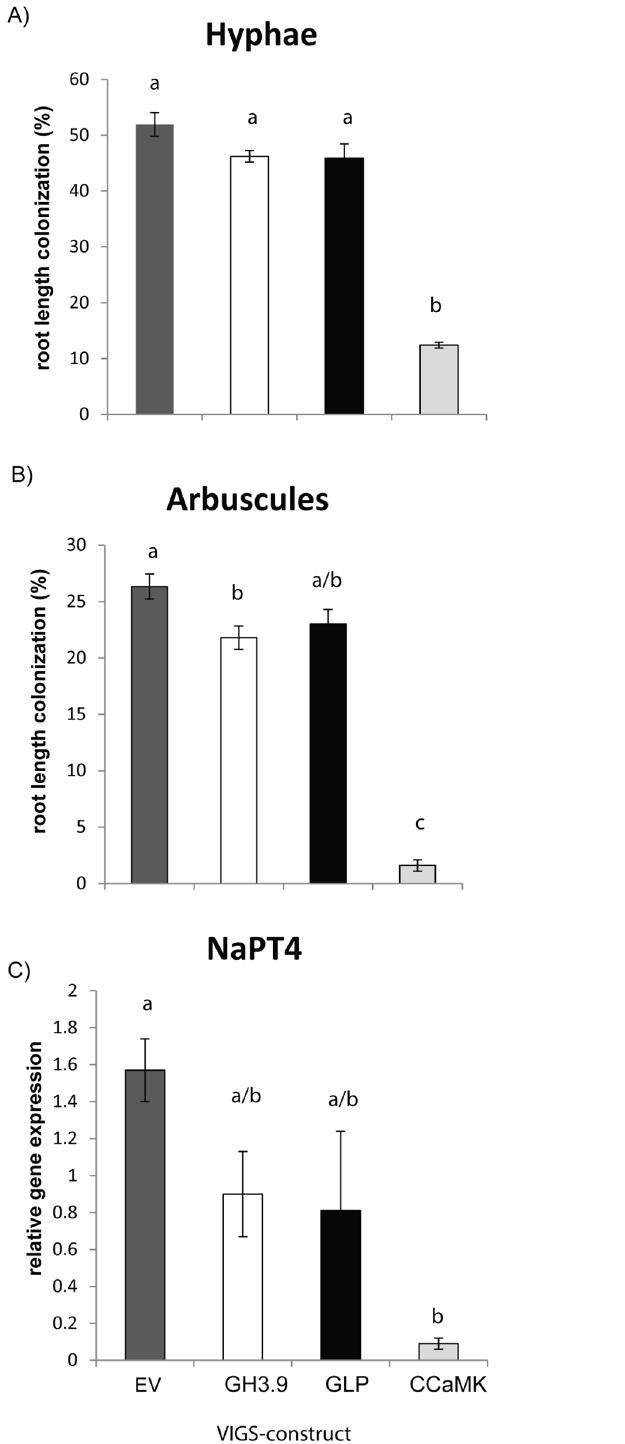
Fig 4. Root length colonization and expression of NaPT4 of virus-infected control plants (EV) and plants silenced for GH3 . 9 , CCaMK and GLP after inoculation with R . irregularis . Nicotiana attenuata plants inoculated with tobacco rattle virus vectors carrying a vector for silencing a putative indole-3-acetic acid-amido synthetase GH3.9 (GH3.9), a germin-like protein (GLP) and a calcium and calmodulin dependent protein kinase (CCaMK), and empty vector (EV) as control. Plants were harvested 28 days